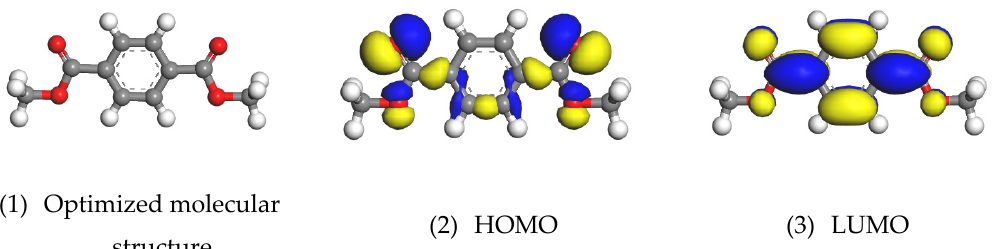
Figure 14. GGA/PW91-optimized structure and highest occupied molecular orbitals (HOMOs) and lowest occupied molecular orbital (LUMOs) of PET molecules.